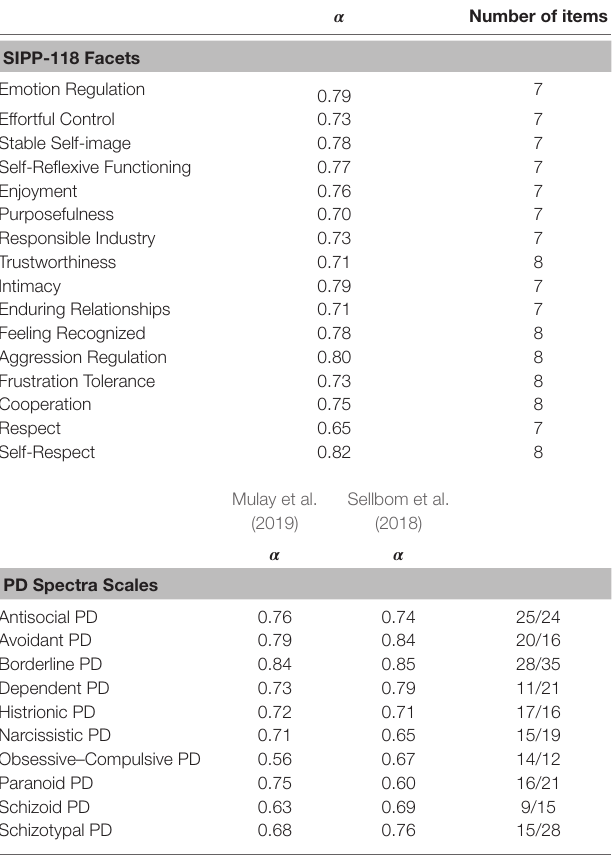
TABLE 1 | Internal Consistency and Item Count for the SIPP-118 Facet and MMPI ( − 2/ − 2-RF) PD Spectra